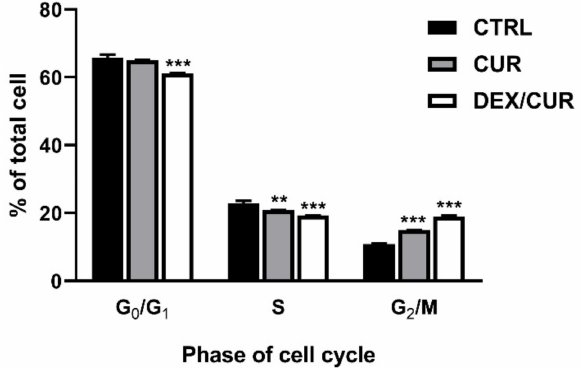
Figure 4. Cycle analysis by flow cytometry of PC-3 cells treated with CUR and DEX/CUR for 24 h at 20 µ M CUR equivalent concentration. Data were reported as mean values ± SD of three independent experiments. Two-way ANOVA followed by Dunnett’s method: ** p < 0.001, *** p < 0.0001 vs.